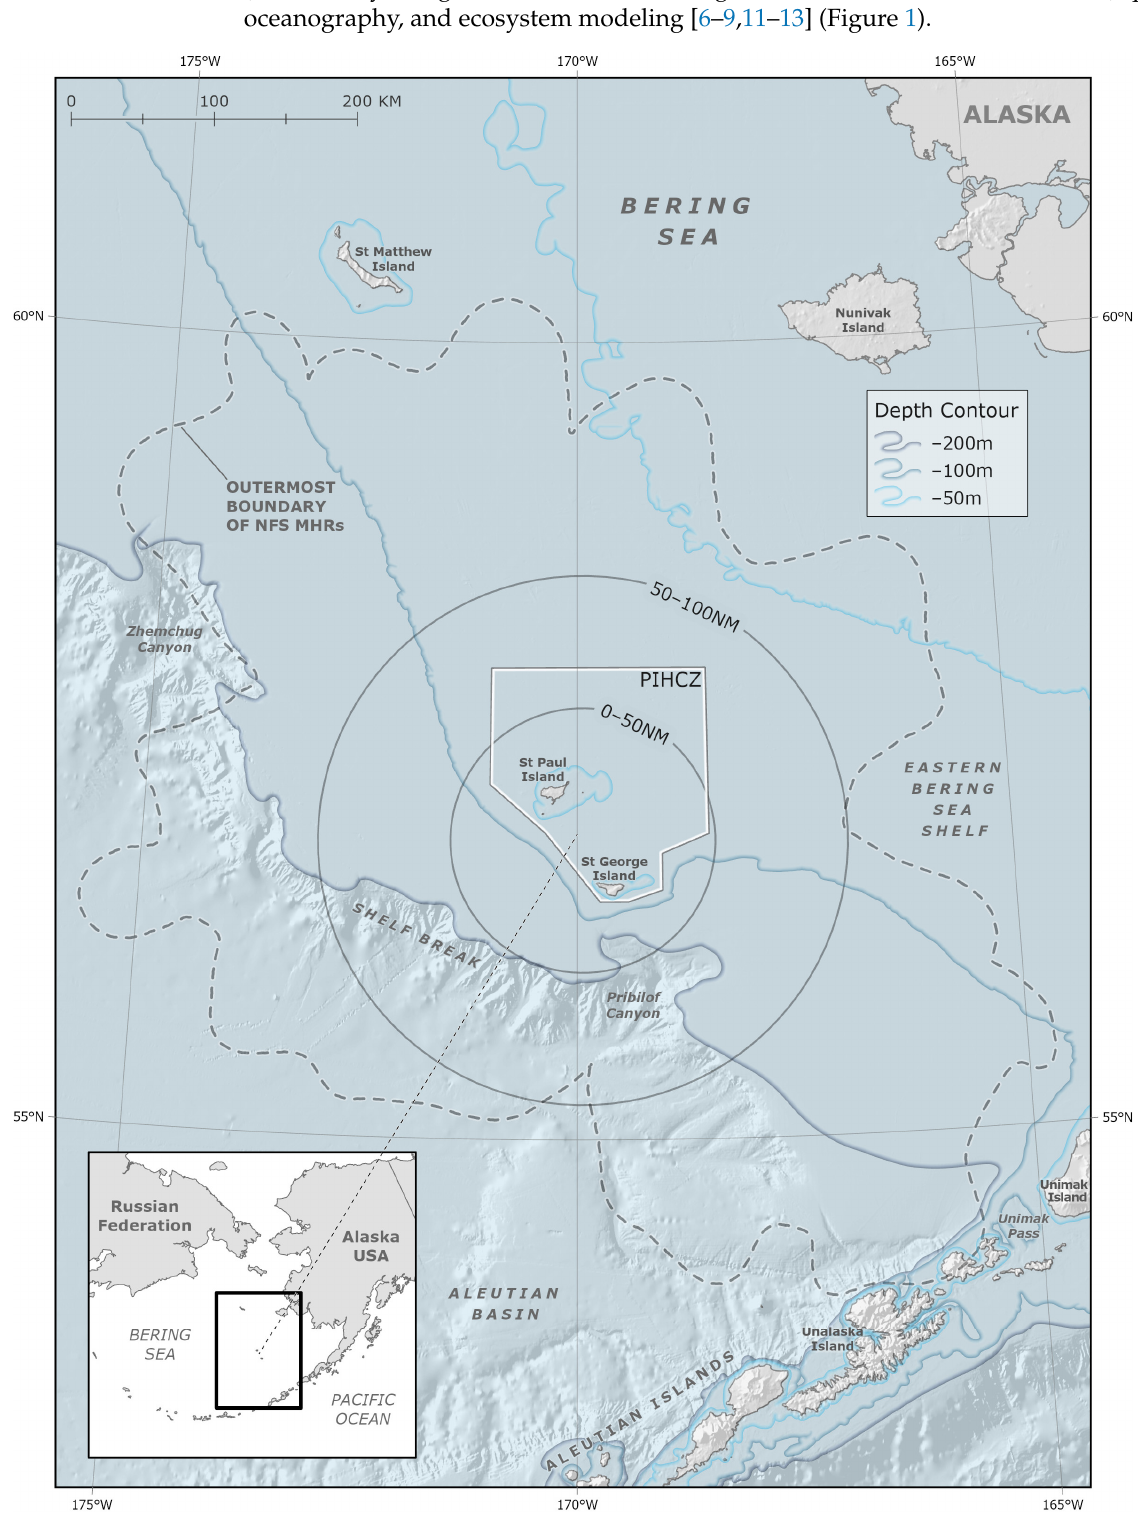
Figure 1. Map showing northern fur seal (NFS) outermost boundary of all meta-home ranges (MHRs) as defined by Robson et al. (2004) around St. George and St. Paul Islands, Alaska (black dashed polygon), and the 0–50 nm and 50–100 nm subzones of the Pribilof Islands Marine Ecosystem (PRIME, black solid polygons). The Pribilof Islands Habitat Conservation Zone (PIHCZ) is shown as a solid white line.